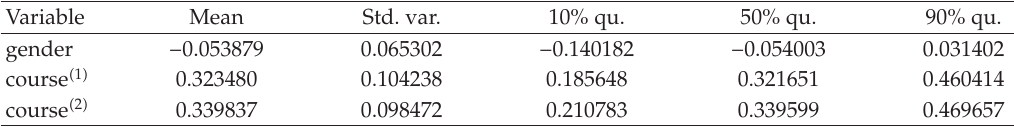
Table 2: Estimates of constant e ff